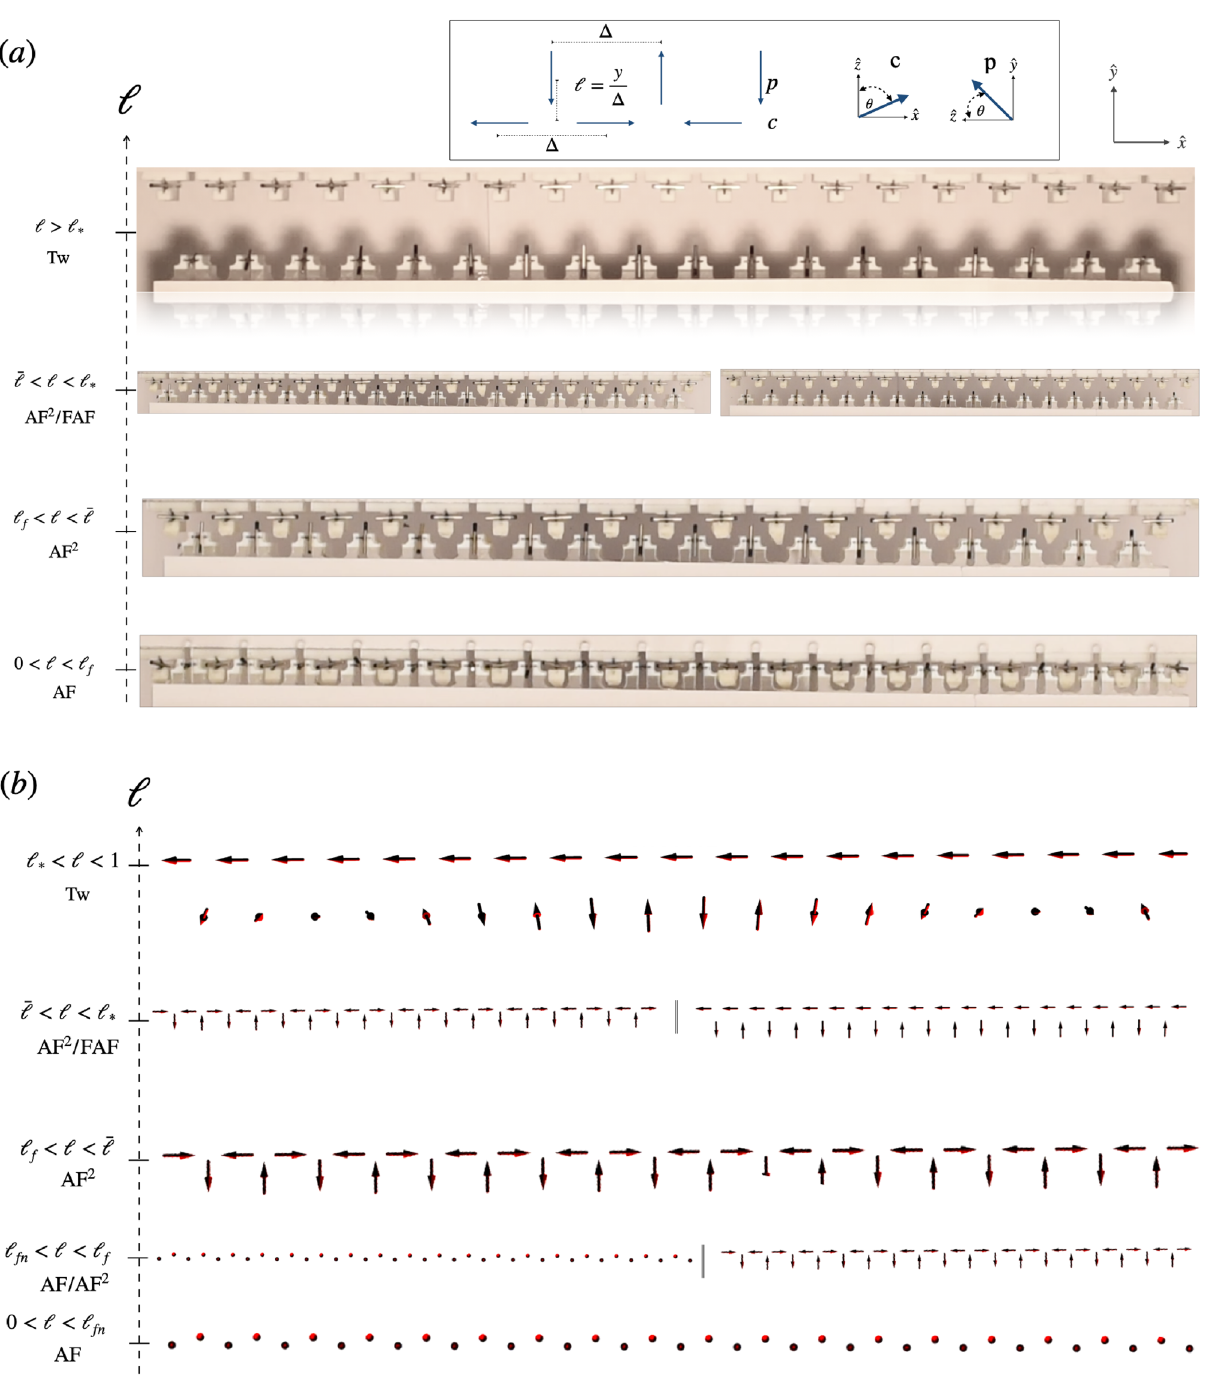
Figure 1. ( a ) Magnetic phases of the experimental zig-zag lattice in terms of ℓ . From top to bottom as ℓ ) the lattice enters the metastable decreases: at large ℓ > ℓ , the system settles in the Tw phase. In the range ( ¯ ℓ , ℓ ∗ ∗ (ℓ f , ℓ) , the AF 2 phase is selected. y plane AF 2 / FAF . As ℓ decreases further, in the range ℓ regime in the x ¯ − ∈ z axis. Inset: At very small gaps ℓ < ℓ f dipoles of both sublattices configure an antiferromagnetic state along the ˆ The zig-zag lattice’s geometry consists of n = 37 Neodymium magnets hinged on top of a PTFE plate. All have 3 [m], radius r 3 [m], mass 0.189 3 [kg], and saturation magnetization 12.7 10 0.79 10 10 length a − − − = × = × × 3 [m] 1.05 10 6 [A/m]. The distance between two consecutive rods in the same chain is (cid:31) 22 10 M s − = × = × y /� where y is the vertical distance measured from chain fixed, and the tunable vertical interchain gap is ℓ = z respectively. ( b ) Screenshots of the lattice from z and y c . Dipoles at chain c and p rotate in the planes x − − Molecular dynamics simulations (see supplemental material 1 for